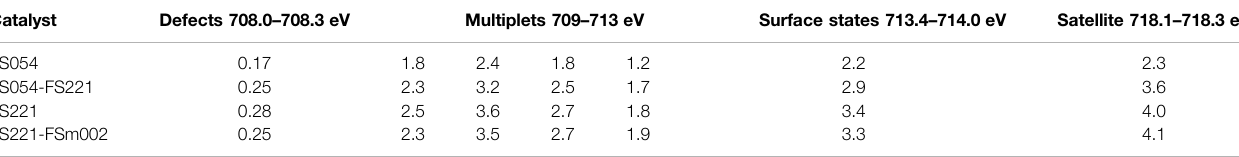
TABLE 3 | The concentration of Fe in different chemical states (in at%) from Fe2p 3/2 XPS